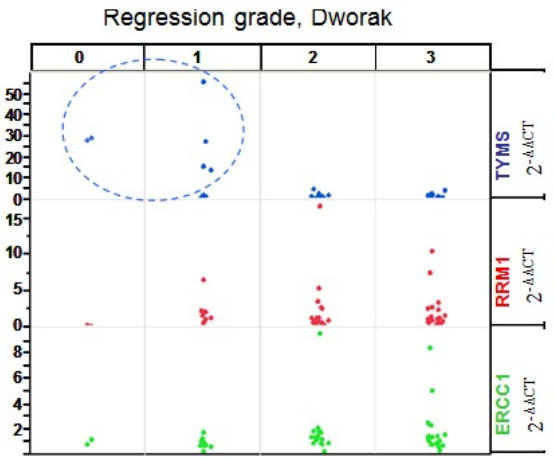
Figure 12. Different relative gene expression profiles for ERCC1 , RRM1 and TYMS ERCC1 and RRM1 show similar expression pattern. It is visible that those patients with an increased TYMS expression showed no or only little tumor response (regression grade 0–1) to 5-FU